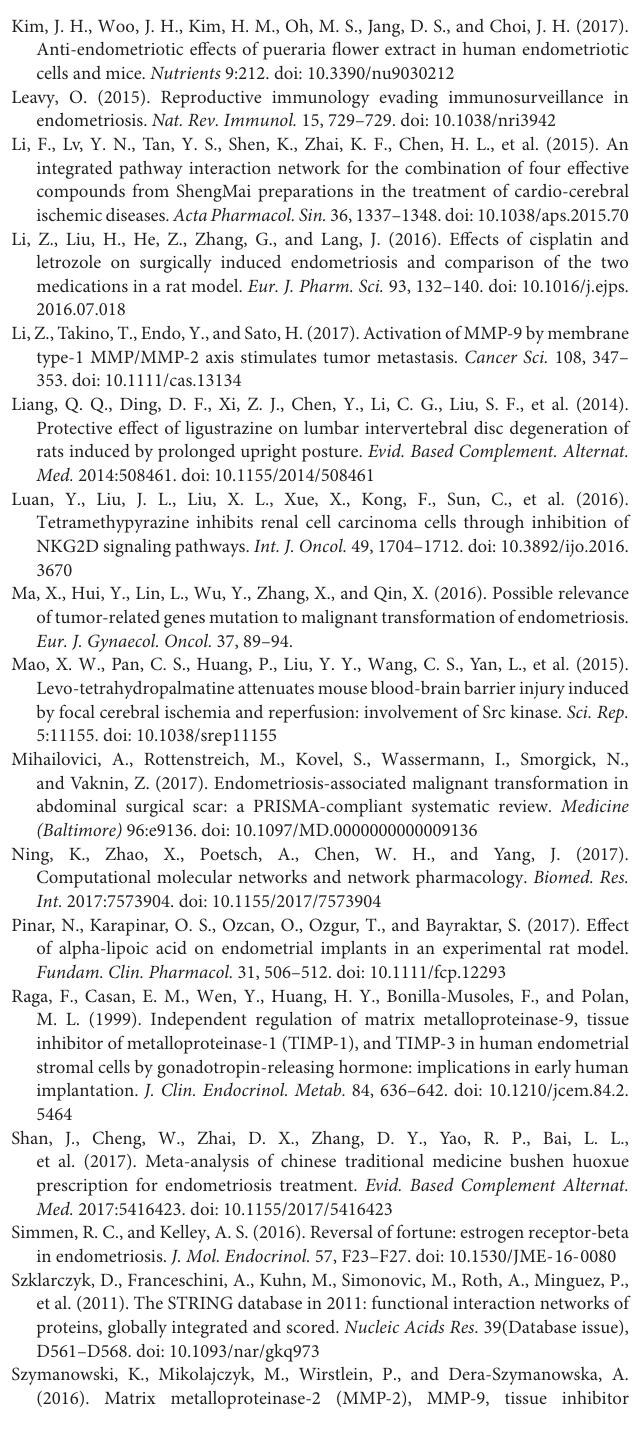
TABLE S4 | 66 key targets extracted from a core protein–protein interaction network. TABLE S5 | GO analysis and KEGG pathway enrichment of 66 key targets from DAVID database. TABLE S6 | GO analysis and pathway analysis of 66 key targets from PANTHER